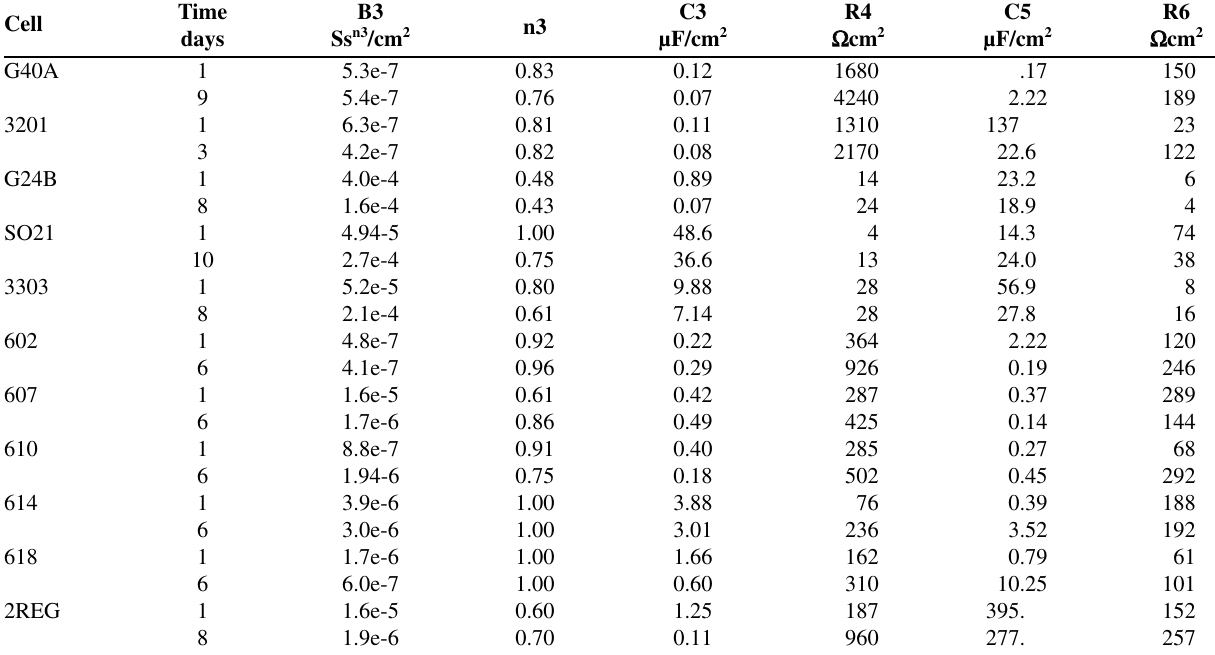
Table 3. Examples of data derived from fitting the impedance spectra to equivalent circiut #1.